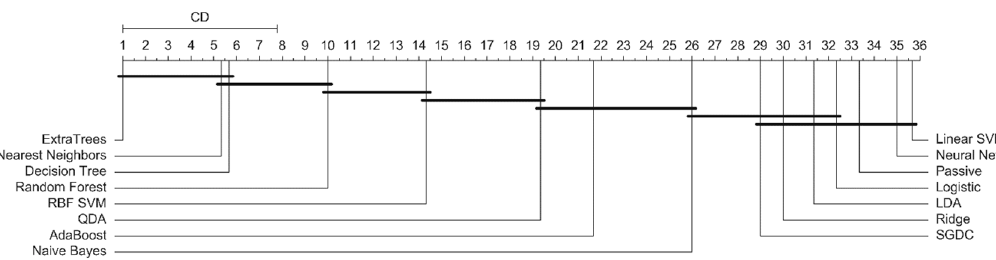
Figure 8. Comparison of mean ranks of final-stage classifiers based on their accuracy performance.